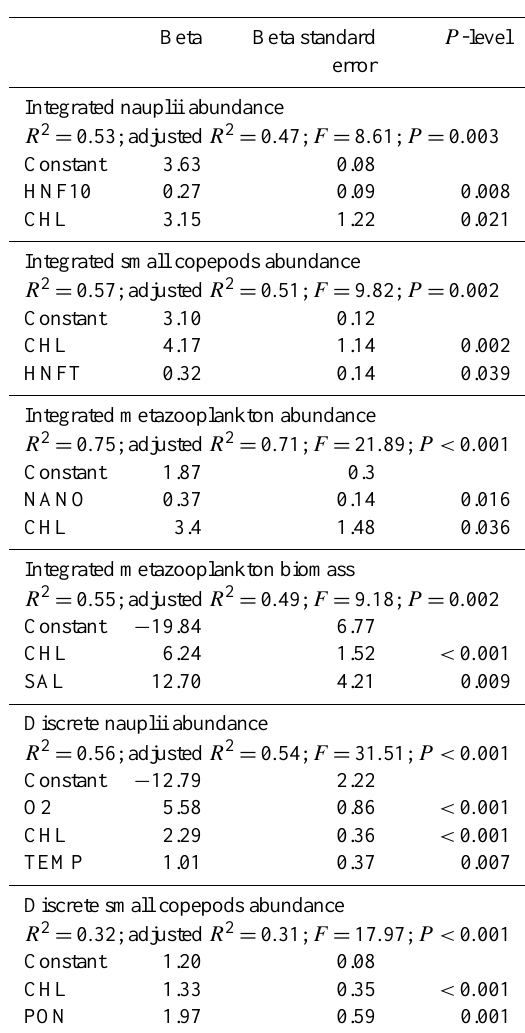
Table 4. Equation parameters of the multiple linear regression mod- els using forward stepwise method explaining the zooplankton pa- rameters distribution. Integrated zooplankton abundance (indm − 3 ) and biomass (mg DW m − 3 ) were obtained from net sampling ( n = 20); discrete abundance of nauplii and small copepod (indm − 3 ) was issued from Niskin bottles ( n = 111 to 140). Symbols of vari- ables are described in Table 3.